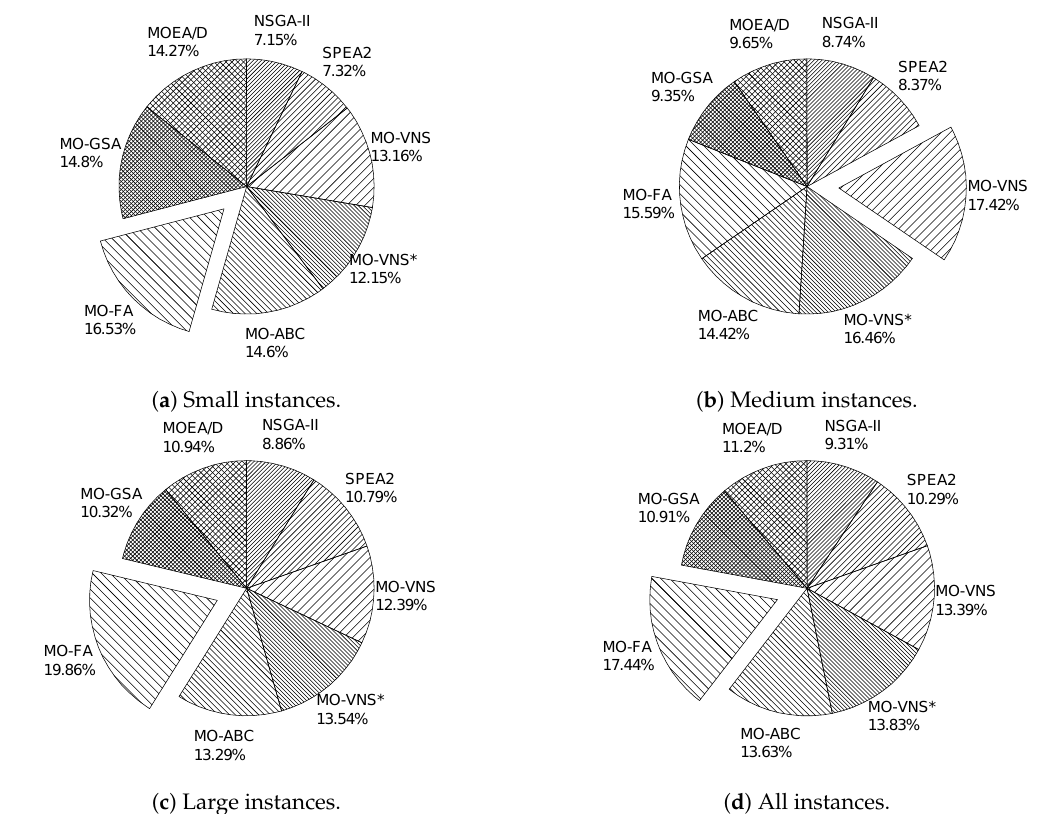
Figure 1. Average performance of the metaheuristics solving the two